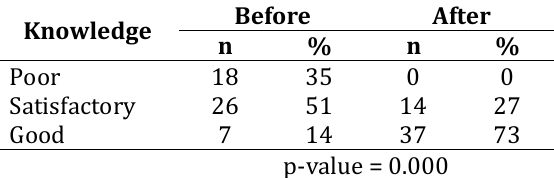
Table 2. The level of knowledge of pregnant women